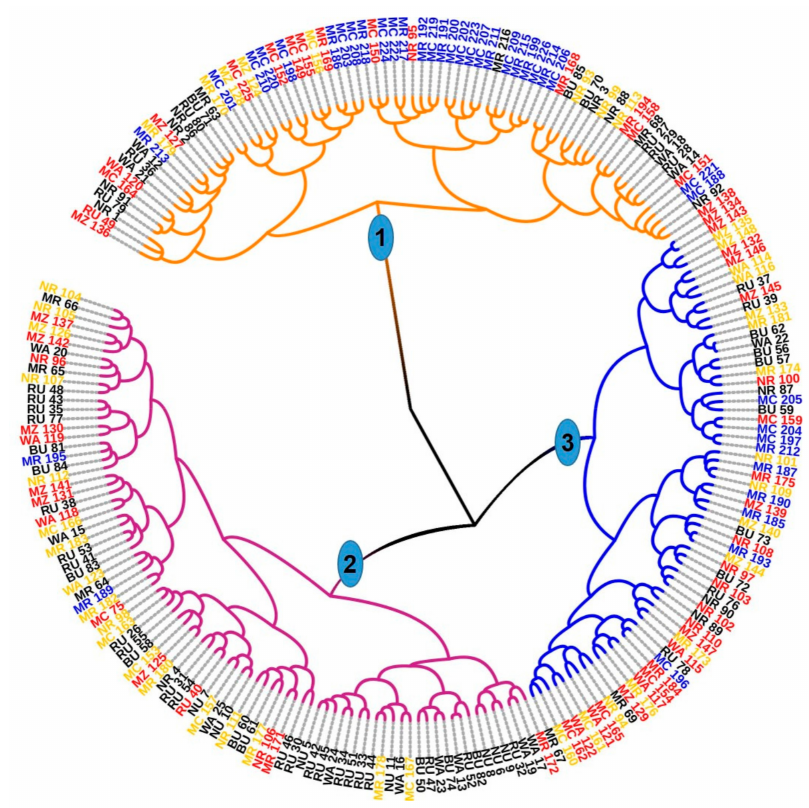
Figure 9. Morphological trait-based dendrogram of the 226 avocado trees, which grouped the trees into three major groups, with each group being composed of individuals from all the four genetic clusters. Note: samples marked with the same color belong to the same genetic